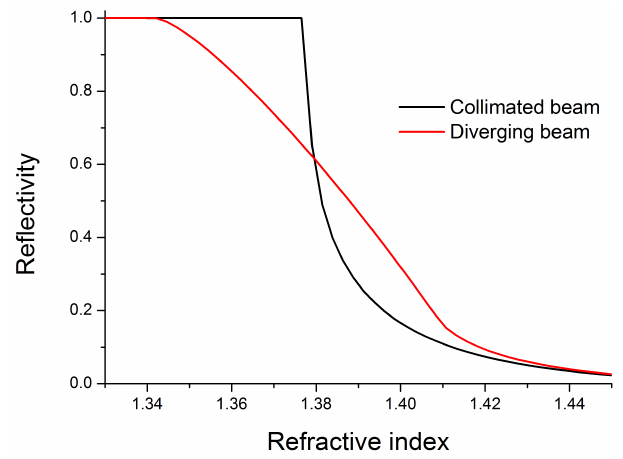
Figure 2. Calculated reflectivities at the solid-liquid interface for different refractive indices. The device with the diverging laser beam shows a linear relation over a large refractive index range, which is advantageous for sample